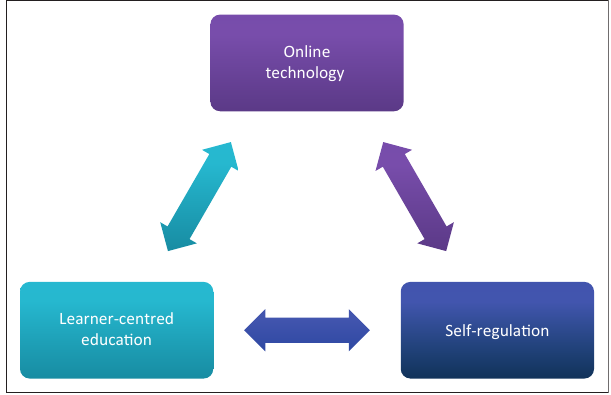
FIGURE 1: The effects of dynamic online technology on teaching and learning